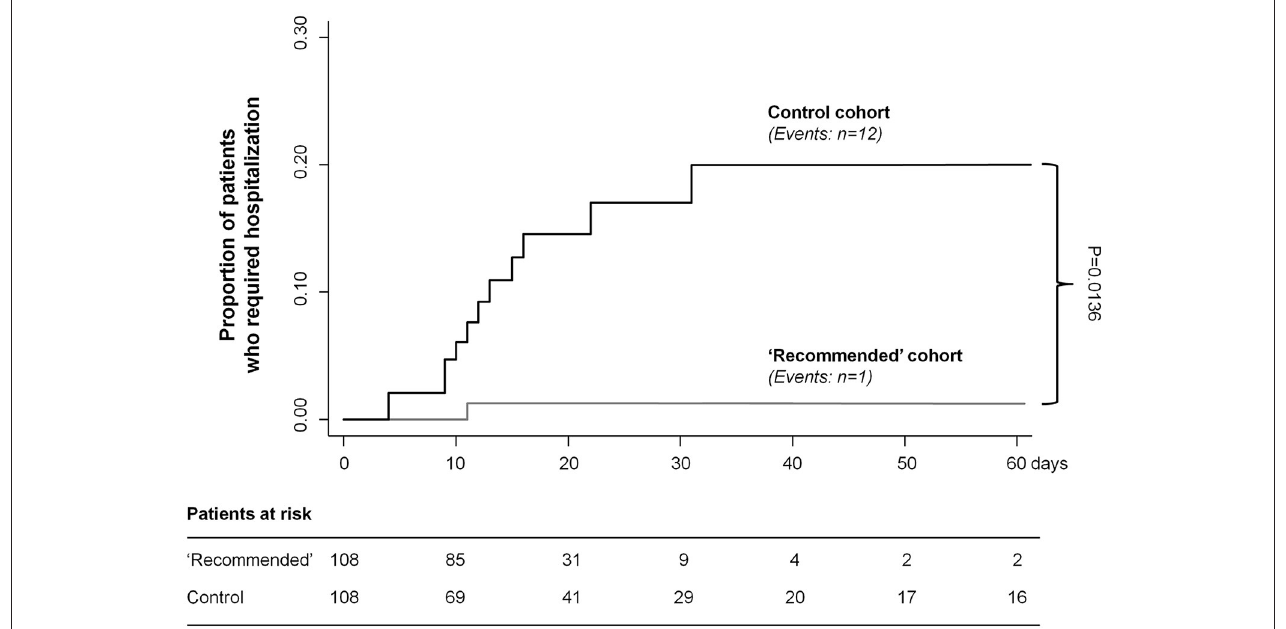
FIGURE 1 | Kaplan–Meier curves for the primary endpoint of hospital admission. Kaplan–Meier curves show the proportion of patients who required hospitalization in the two treatment cohorts. Gray line, “recommended algorithm” treatment cohort; black line, “control” cohort. P -value for treatment comparison was assessed by survival analysis for clustered